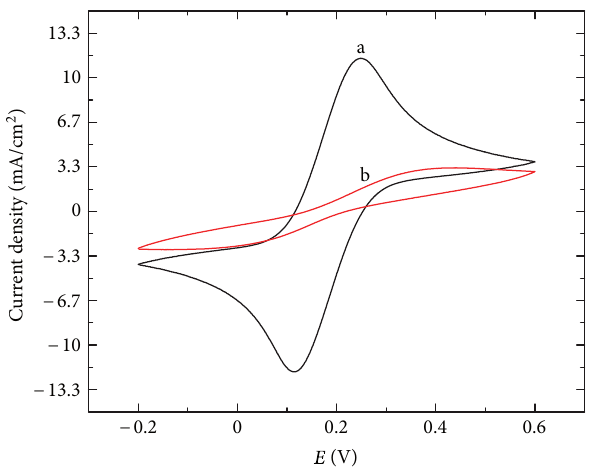
DTC/AuNPs electrode 6